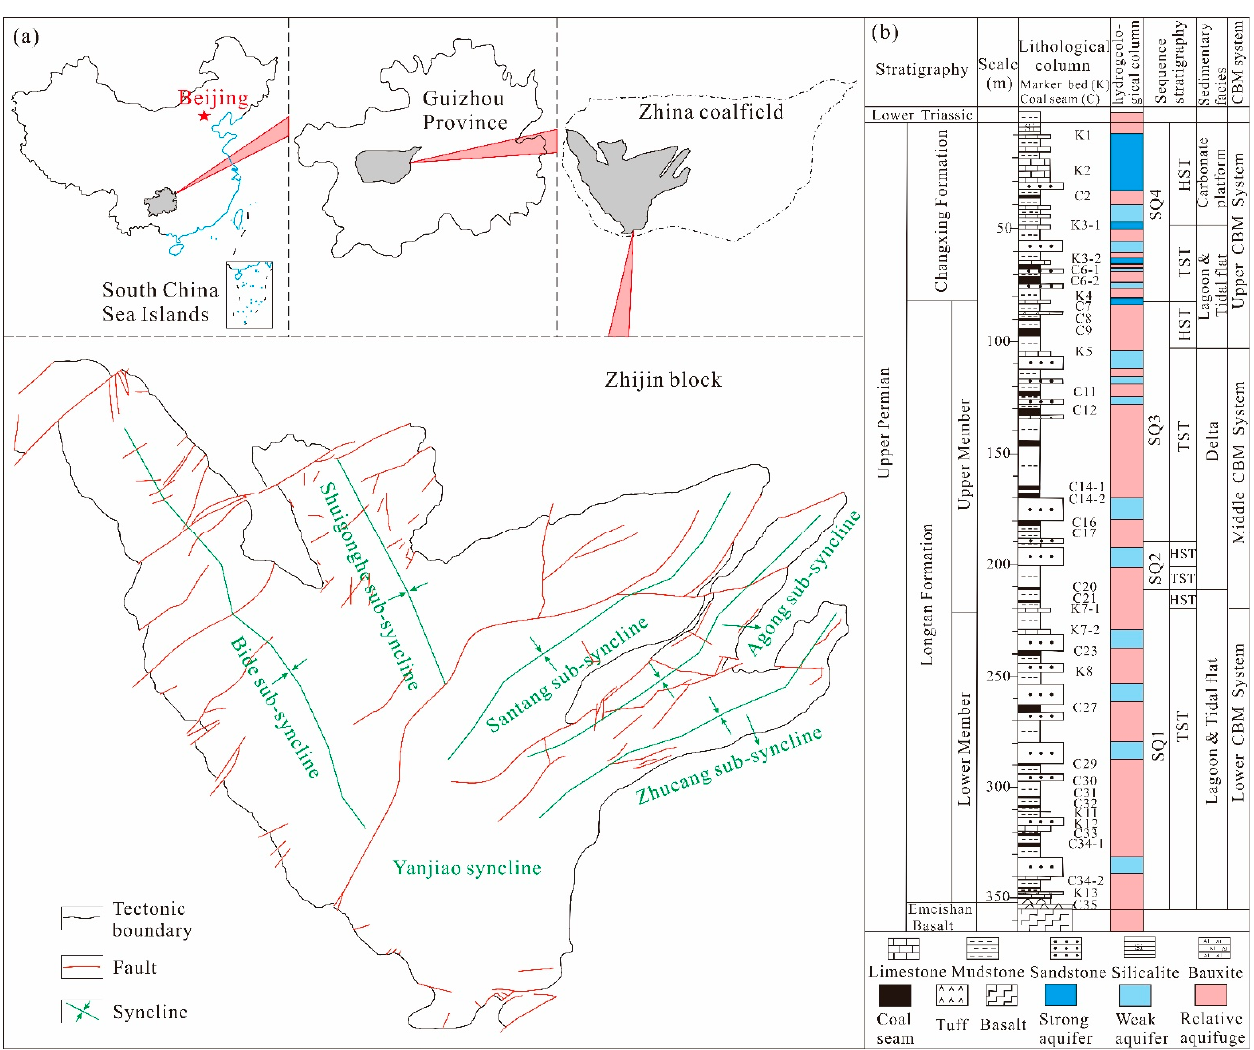
Figure 1. Geological setting of the Zhijin block, Western Guizhou. ( a ) Tectonic map. ( b ) Stratigraphic column.